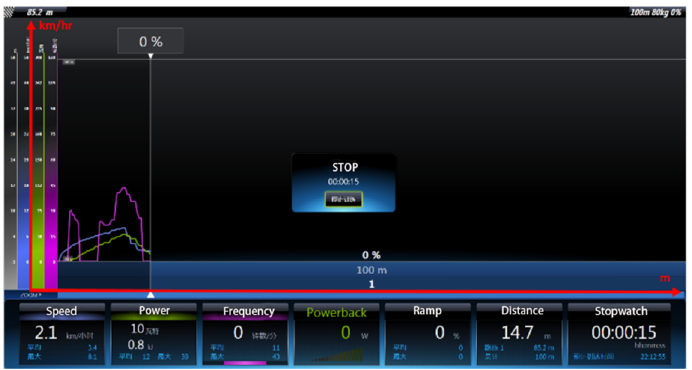
Figure 19. Results for road slope − 5%, cyclist weight 40 kg, and electromagnetic reversal braking.